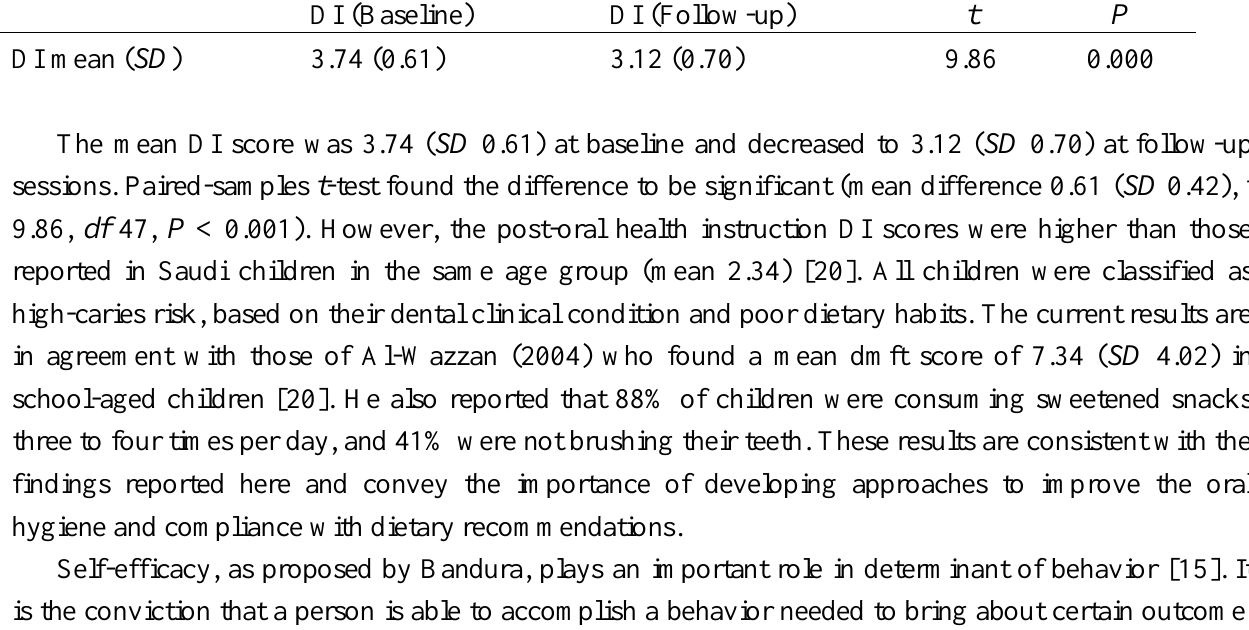
Table 5. Debris Index (DI) Mean Scores at Baseline and After One-Week of Oral Health Education DI (Baseline) DI